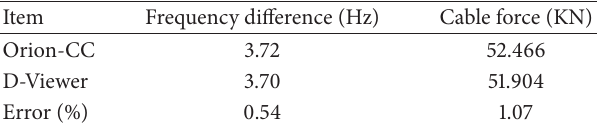
Table 2: Comparison of the results from Orion-CC and